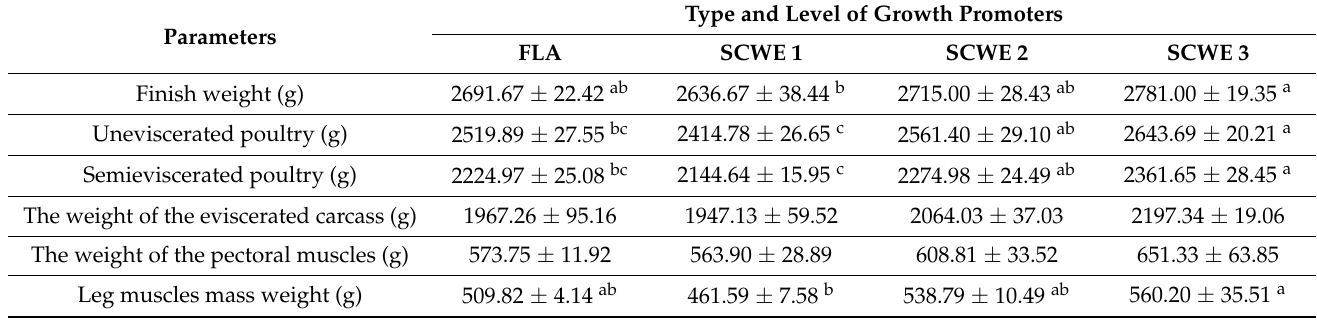
Table 6. The quality of the carcass of broiler